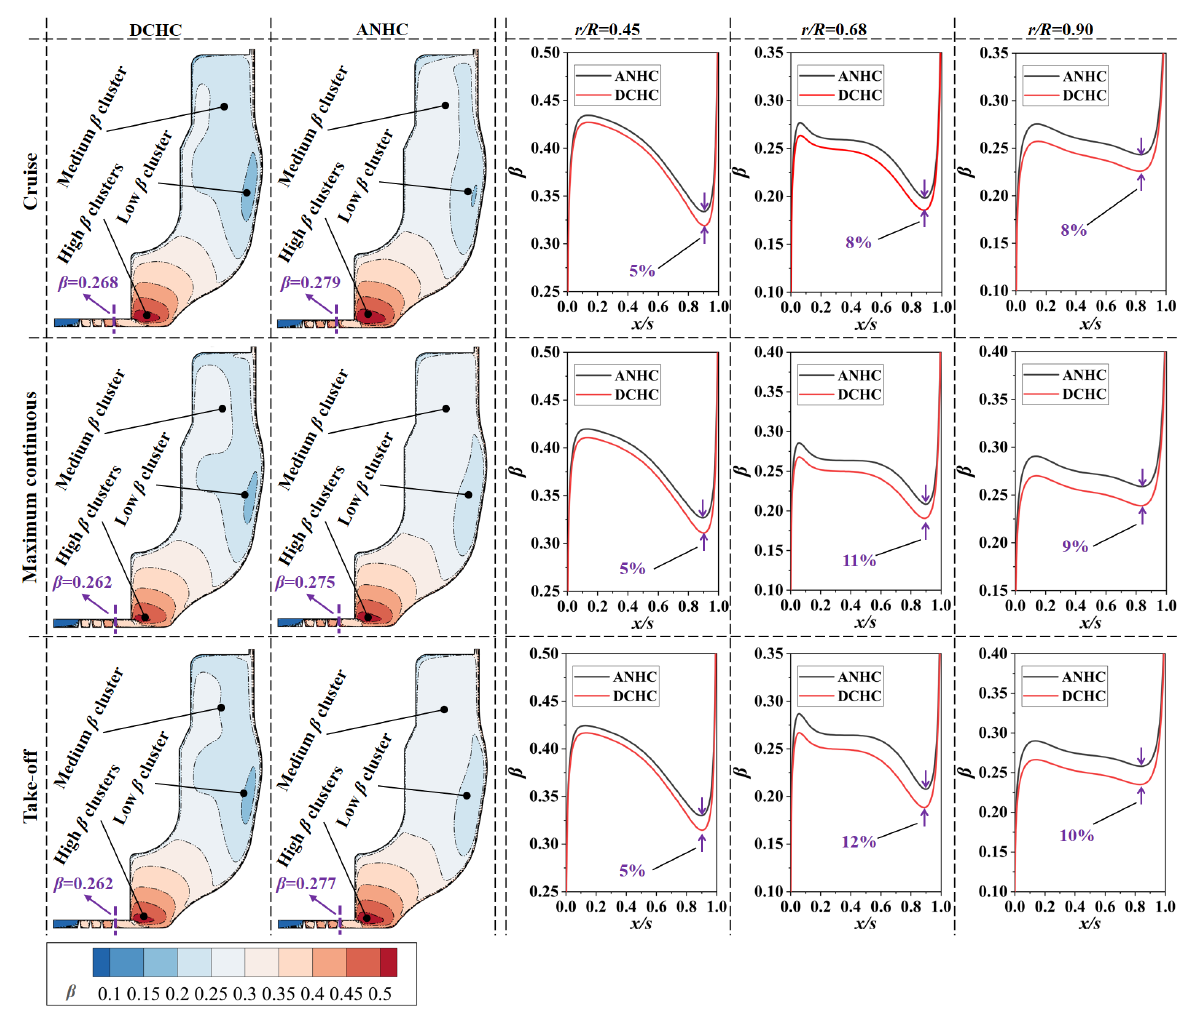
Figure 31. Swirl ratio distributions in the axial direction under ANHC and DCHC.